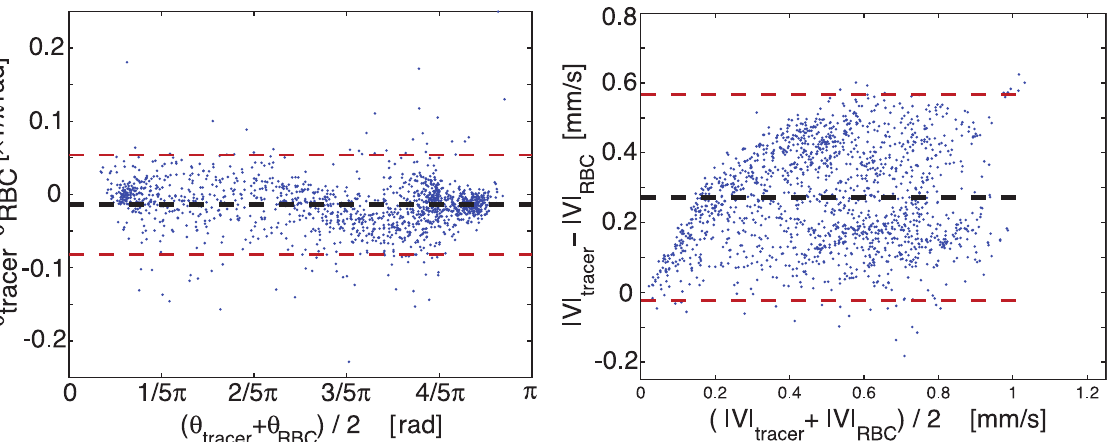
Figure 7. Origin of discrepancy. Bland-Altman plots of the angle ( left ) and magnitude ( right ) of the measurements using laser = tracers and led = red blood cells. M ~ 25 | . The error in angle is relatively small compared to the error in magnitude.